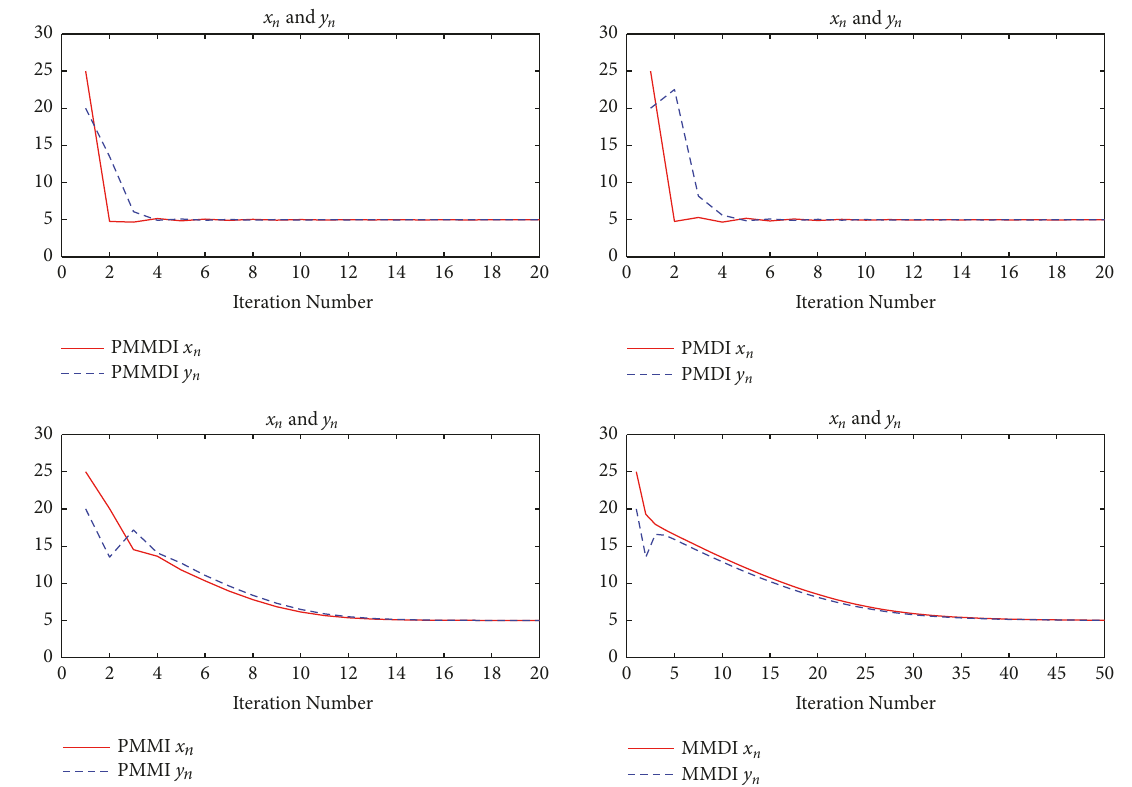
Figure 2: Iterative solutions of (PMMDI), (PMDI), (PMMI), and